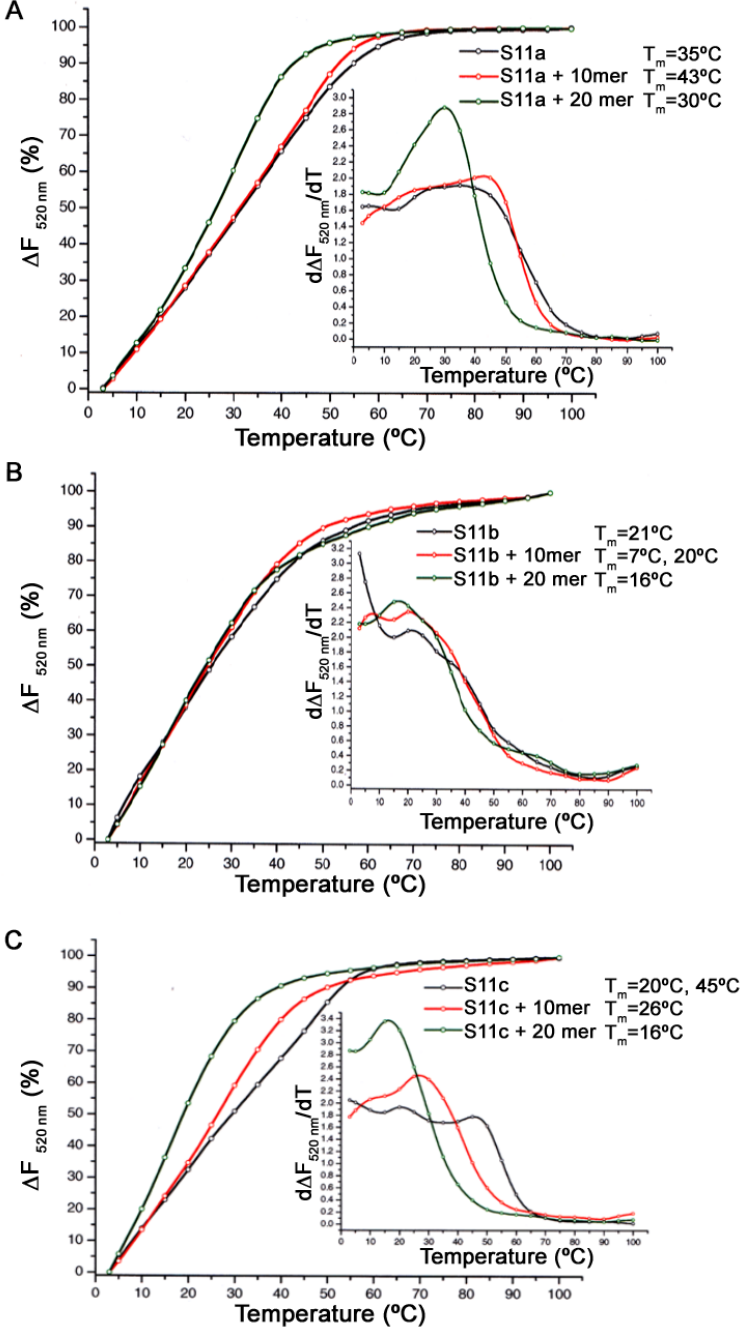
Figure 4. Thermal denaturation of ( A ) S11a, ( B ) S11b, and ( C ) S11c. Comparison of the fluorescence melting profiles of S11a, S11b and S11c with the 10mer and 20mer peptides.